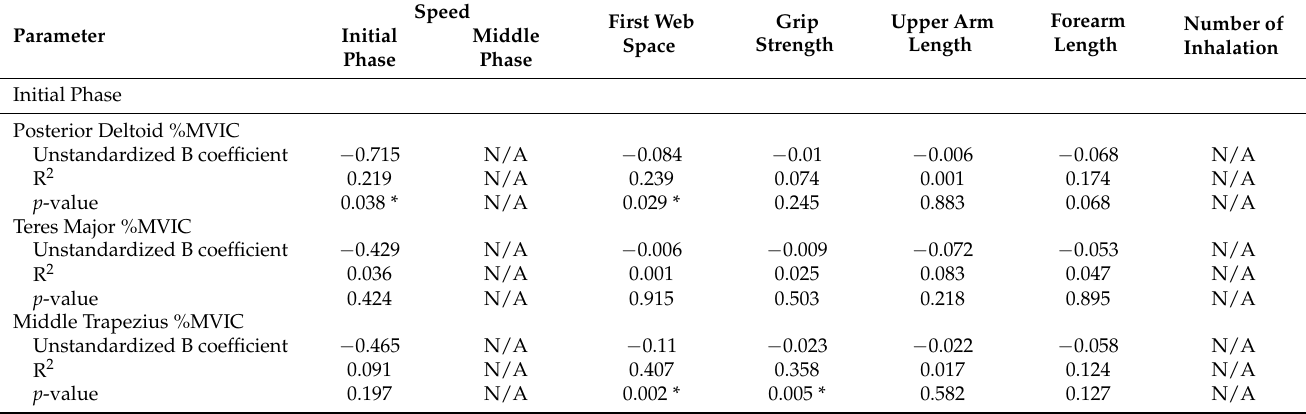
Table 6. Summary of correlation between muscle activity and speed, anthropometry, and skills .